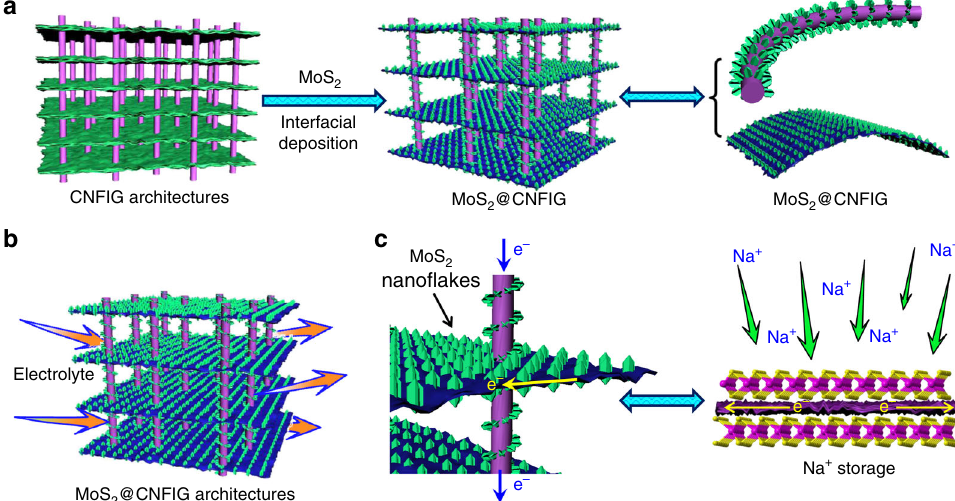
Fig. 3 Schematic illustration of the preparation of MoS 2 @CNFIG hybrid and sodium ions storage. a Schematic illustration of the homogeneous deposition of layered MoS 2 nano fl akes on CNFIG matrix, b porous morphology of MoS 2 @CNFIG hybrid accelerates the rapid penetration of electrolyte, and c quick sodiation/desodiation and large sodium ions storage capabilities of MoS 2 @CNFIG hybrid due to excellent electrical